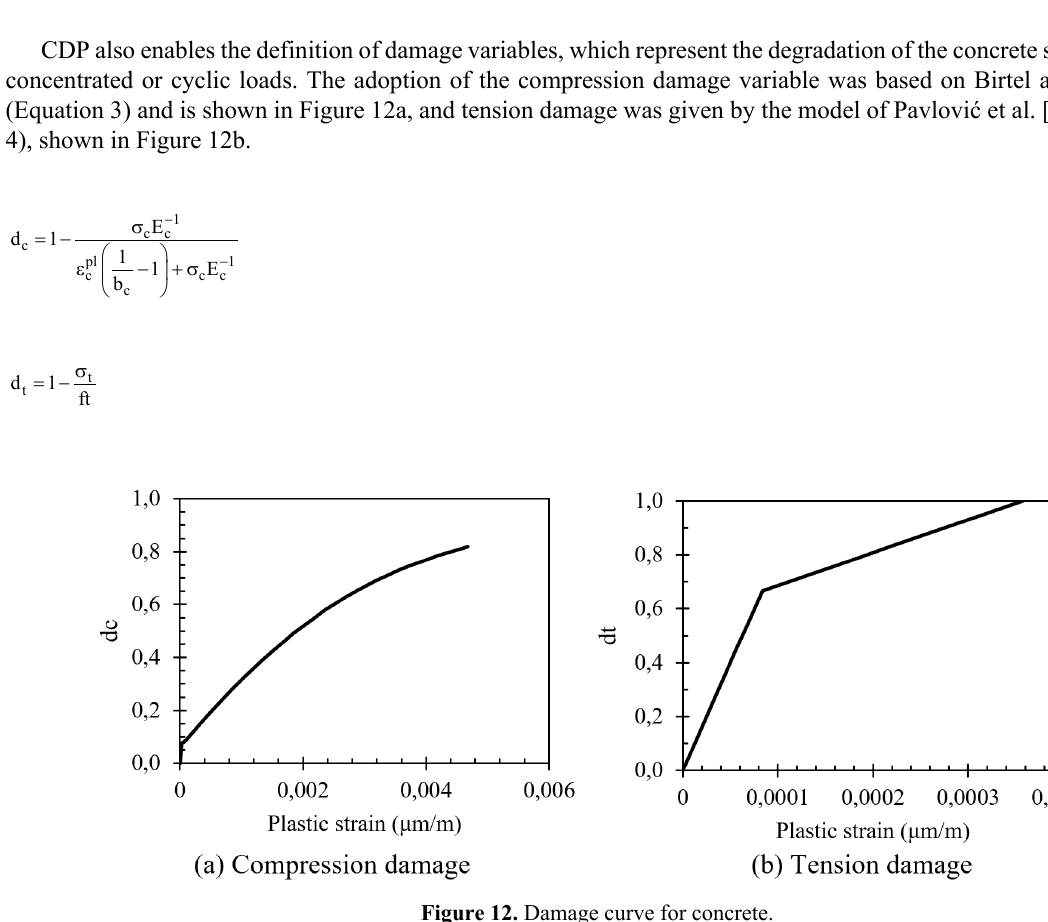
Figure 12. Damage curve for